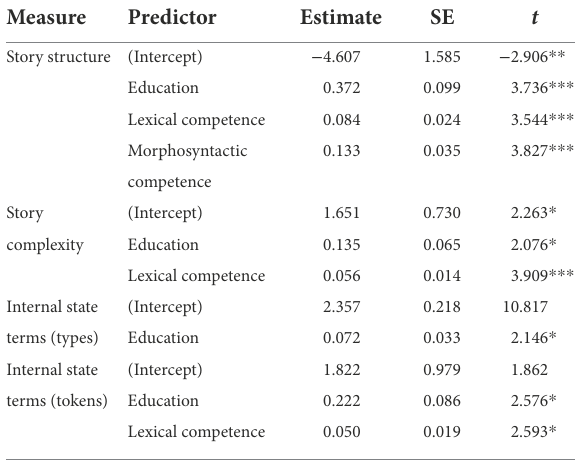
TABLE 3 Significant terms in the final model for performance in each outcome measure of macrostructure competence in the first round of analyses.